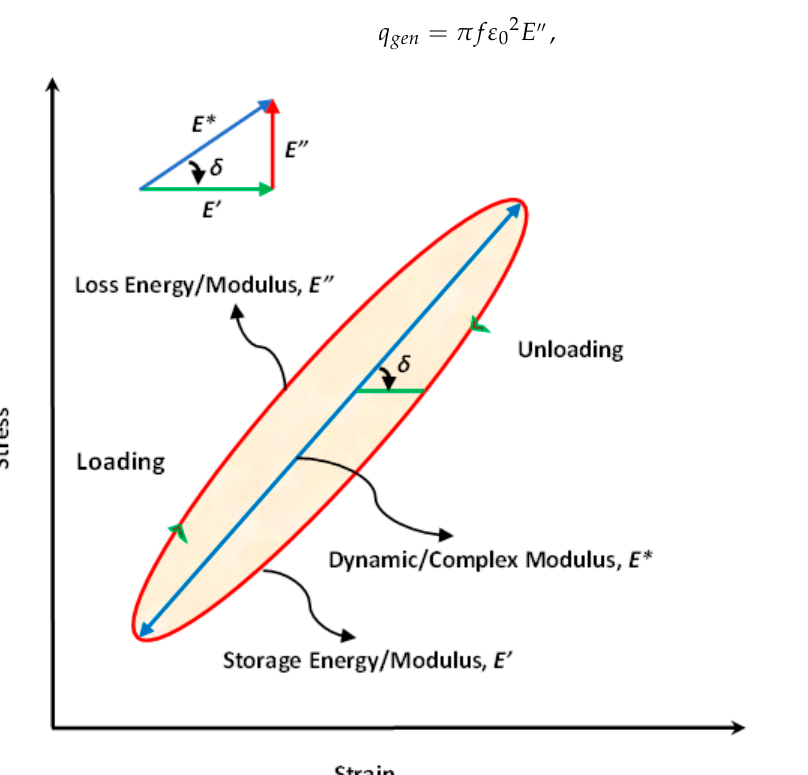
Figure 12. Schematic demonstration of the generated thermal energy for a polymer-based structure due to phase lag between stress and strain over an entire cycle [49].